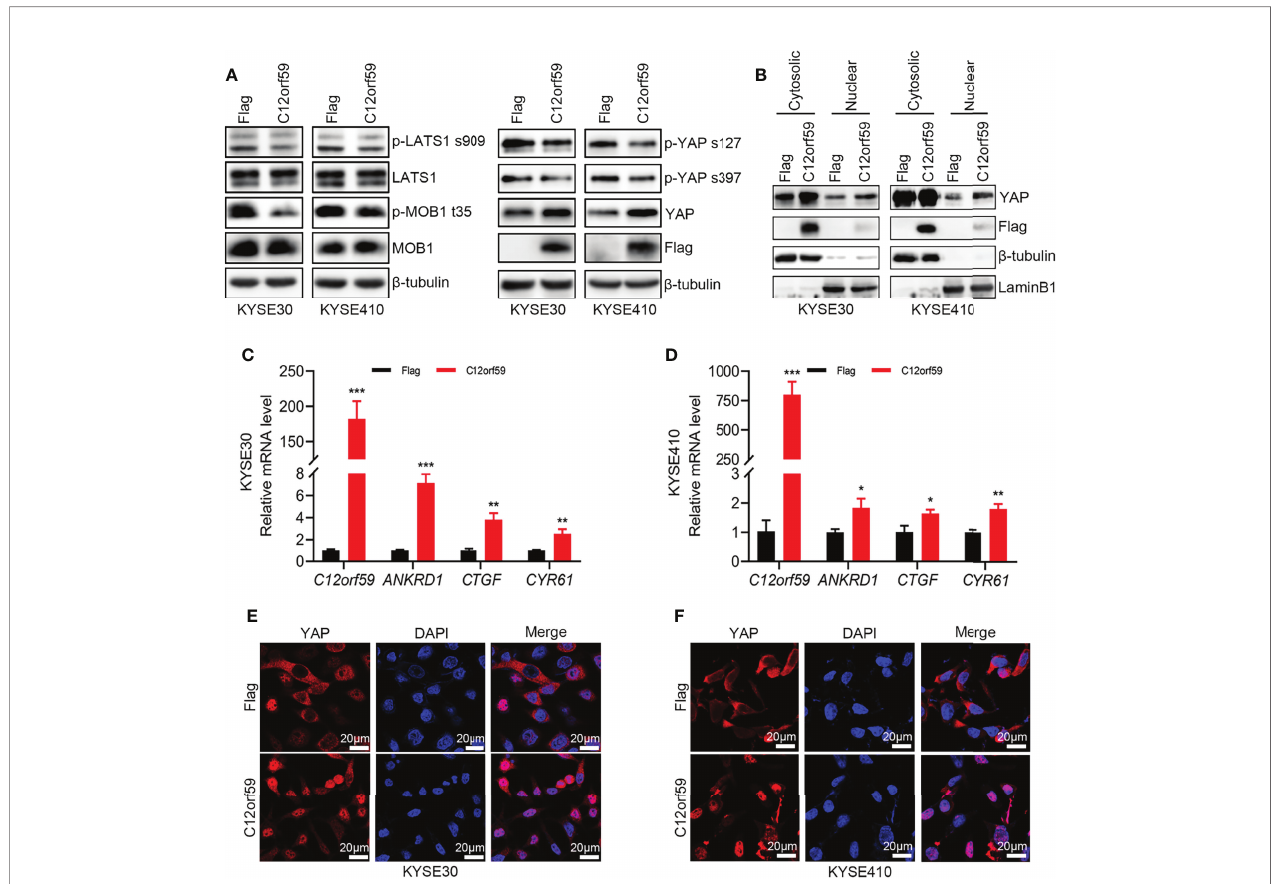
FIGURE 4 | C12orf59 induces YAP nuclear localization. (A) Western blotting was used to measure the phosphorylated levels of LATS1 (p-LATS1), MOB1 (p-MOB1) and YAP (p-YAP) in KYSE30 and KYSE410 cells with infection of control or C12orf59-expressing lentivirus. (B) Cytosolic and nuclear extracts from KYSE30 or KYSE410 cells with or without C12orf59 overexpression were subjected to western blotting for YAP. b -tubulin was used as the loading control for whole or cytosolic lysates, and LaminB1 was used as the loading control for nuclear extracts. (C, D) Expression of C12orf59 and the YAP target genes ANKRD1 , CTGF , and CYR61 in control and C12orf59-overexpressed KYSE30 and KYSE410 cells were detected by real-time PCR. RPL19 was used as the internal control for real-time PCR. (E, F) Sub-cellular distribution of YAP (red) was examined in control and C12orf59-overexpressed KYSE30 and KYSE410 cells by immuno fl uorescence. Nuclei were stained with 4 ′ ,6-diamidino-2-phenylindole (DAPI; blue). Scale bar, 20 m m. BF, bright fi eld. Data were presented as mean values with standard deviations, * p < 0.05; ** p < 0.01; *** p <